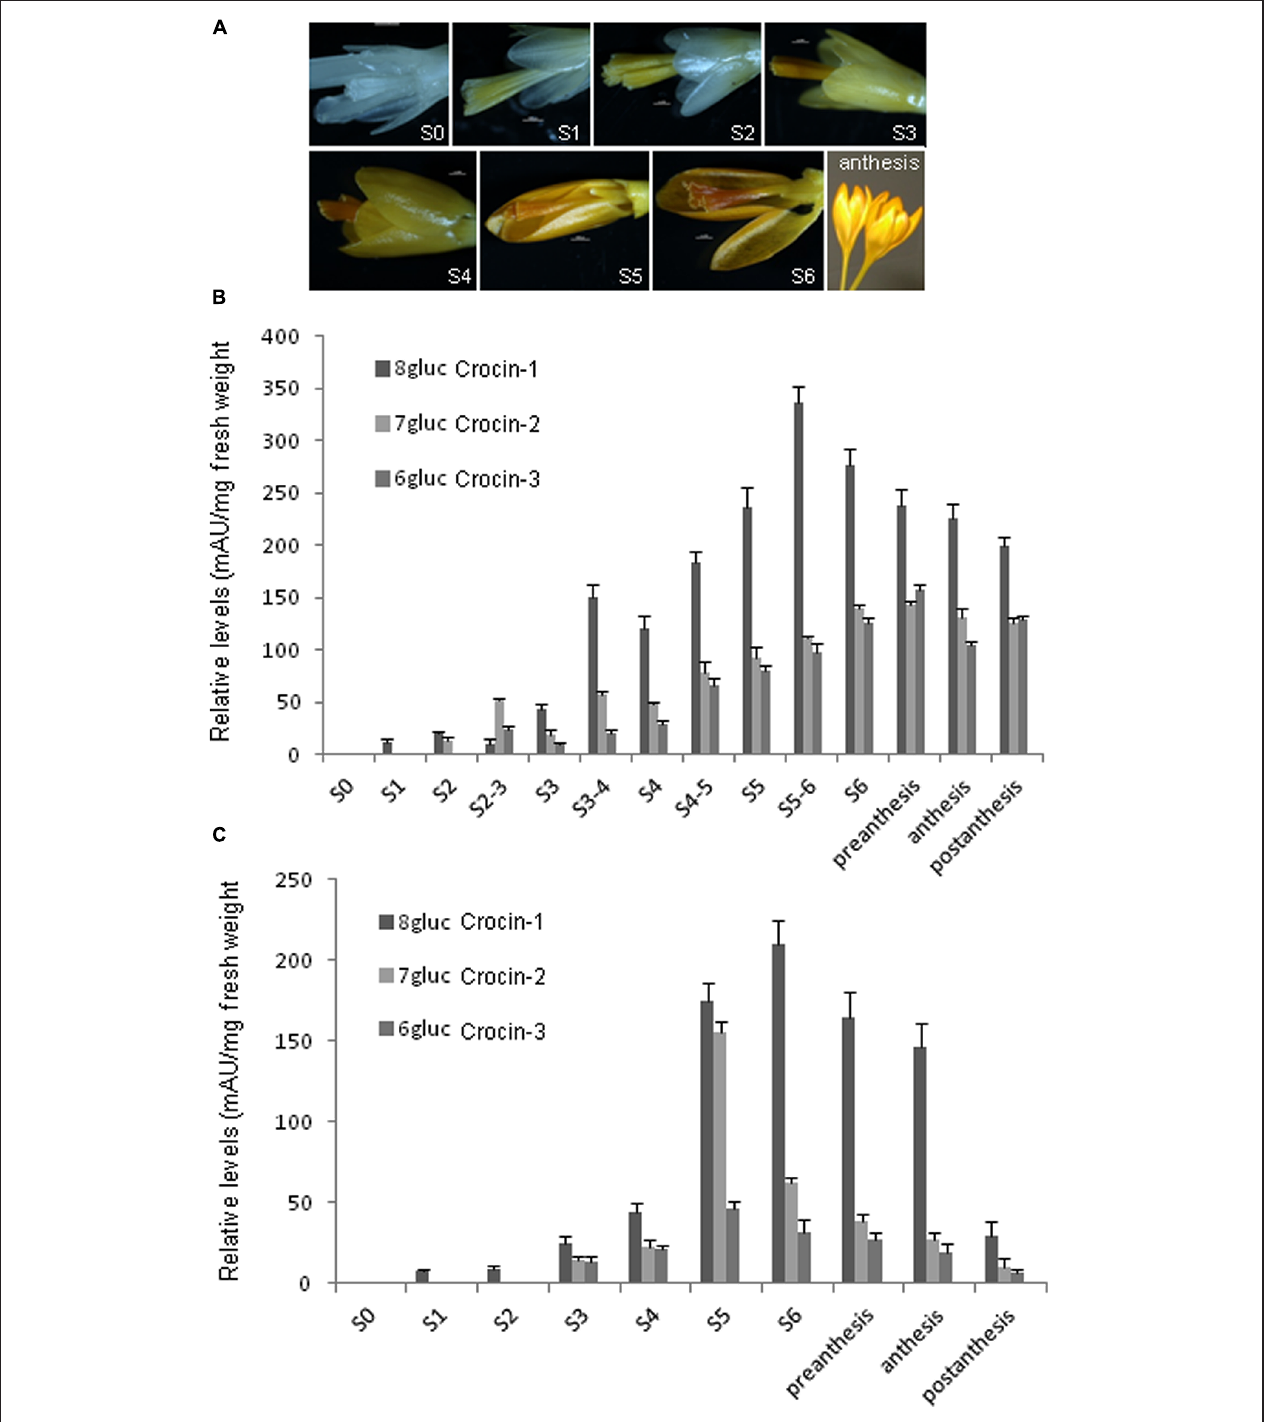
FIGURE 3 | Stigma and tepal development is characterized by the increasing yellow to orange coloration, due to crocins accumulation, until the flower reaches the anthesis stage. (A) Eight developmental flower stages characterized by color development. Stage 0 (S0): white stigma and white tepals; stage 1 (S1): yellowish stigma and white tepals; stage 2 (S2): yellow stigma and yellowish tepals; stage 3 (S3): orange stigma and yellow tepals; stage 4 (S4): dark orange stigma and dark yellow tepals; stage 5 (S5): dark orange stigma and orange tepals; stage 6 (S6): dark orange stigma and dark orange tepals; anthesis, open flower. Scale bars S1–S6: 1000 μ m. (B) Levels of crocins with eight (crocin-1), seven (crocin-2), six (crocins-3), and two glucose molecules in stigma at different developmental stages. (C) Levels of crocins with eight (crocin-1), seven (crocin-2), six (crocin-3), and two glucose molecules in tepals at different developmental